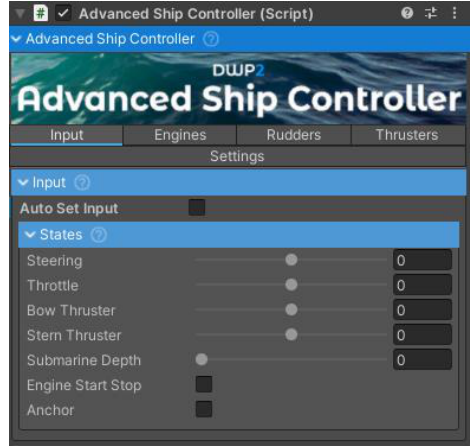
Figure 17. The “ Advanced Ship Controller ” component.